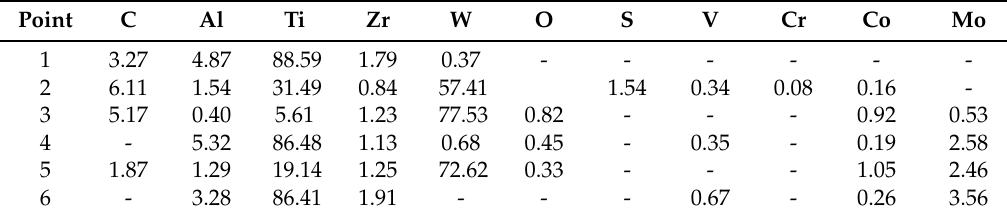
Table 4. EDS analysis of the wear region of the carbide insert (wt. %, check points refer to Figure 5).